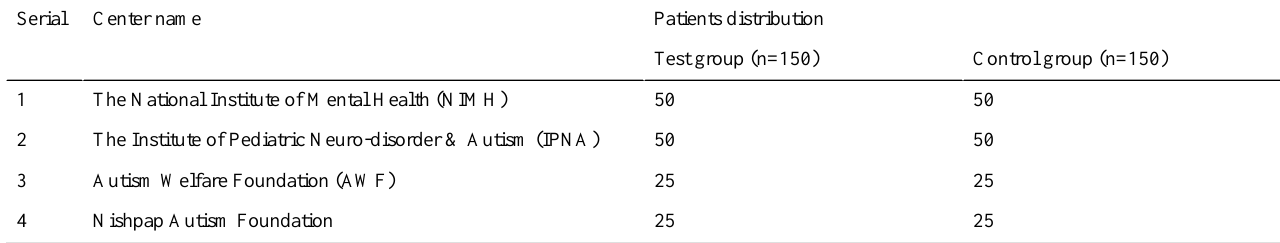
Table 1. Patient distribution among the 4